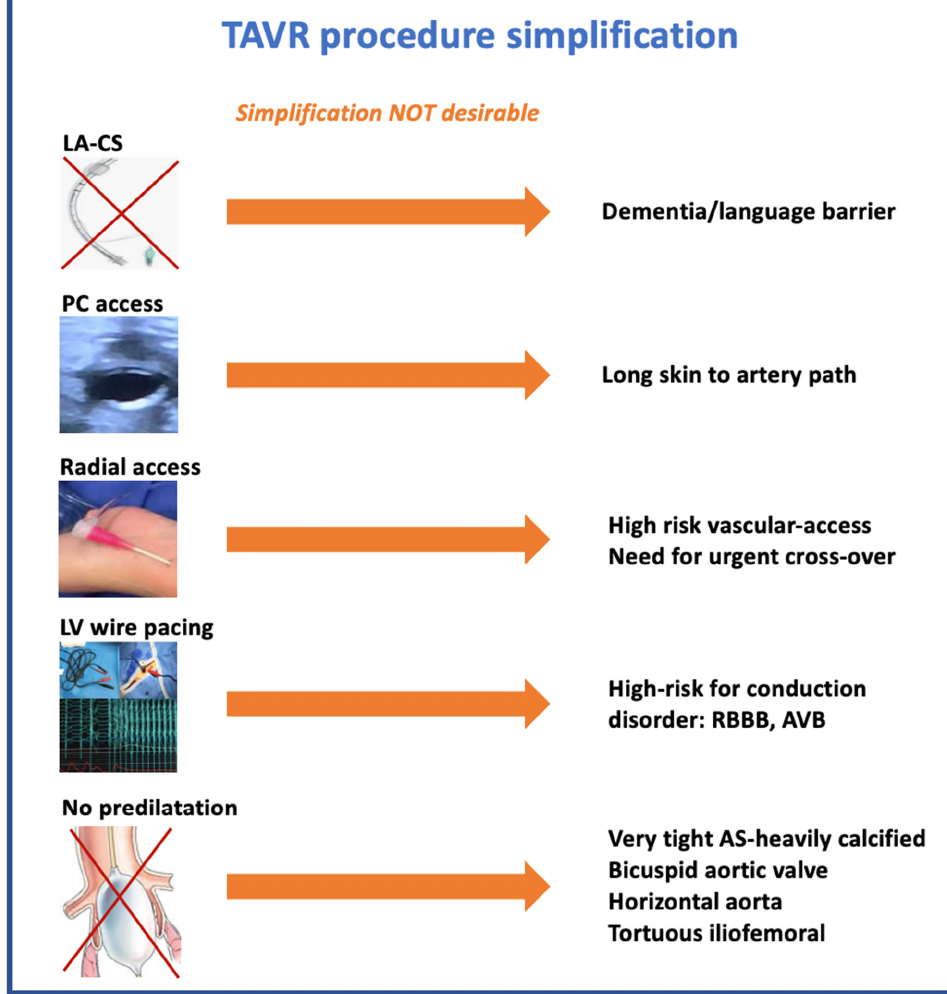
Figure 1. TAVI procedure simplification strategy: desirable or not .